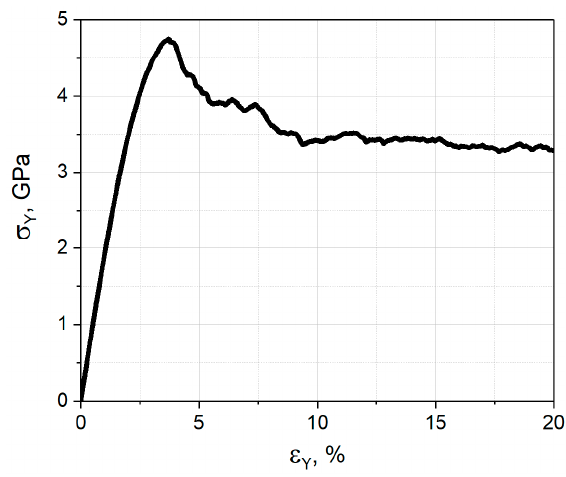
Figure 8. Stress–strain dependence for the bcc30_L1 sample under compression.